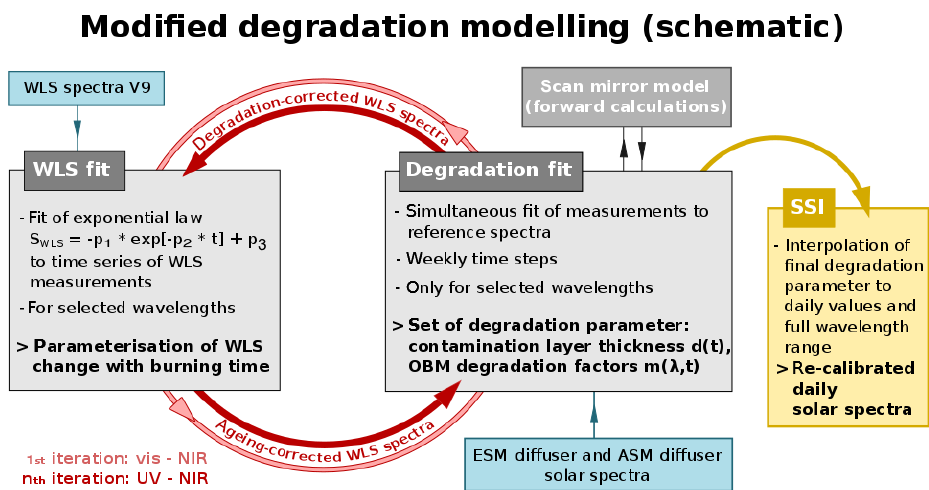
Figure 6. Schematic representation of the degradation modelling (details see text).